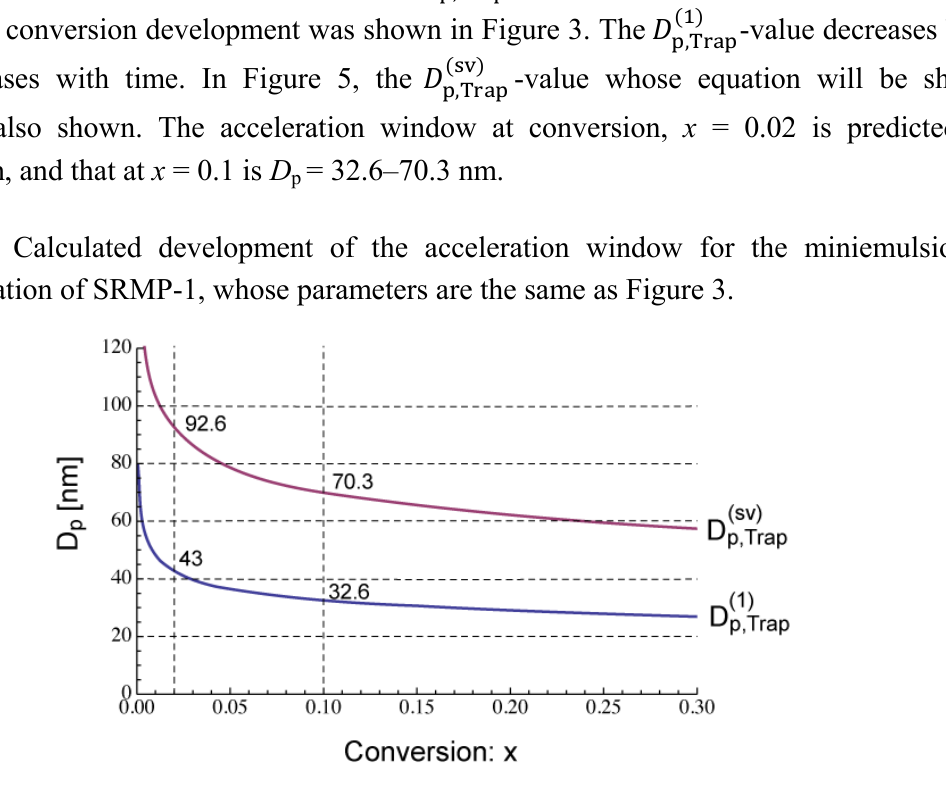
. The lower limit of the p